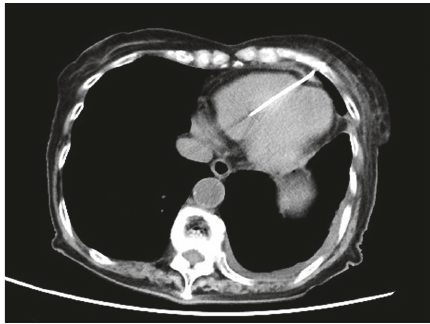
Figure 3: Intraoperative view of the lead penetrating the right ventricular